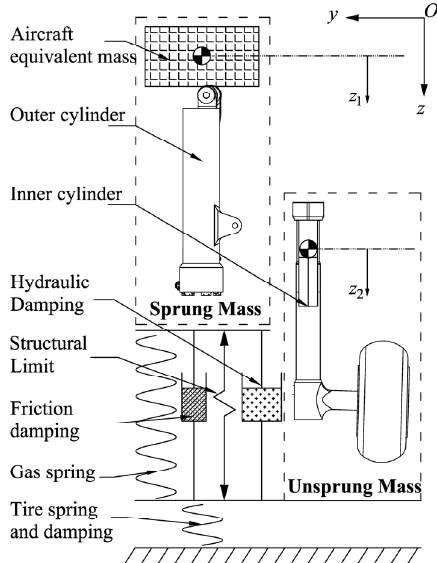
Figure 1. Schematic of the landing gear with two degrees of freedom.